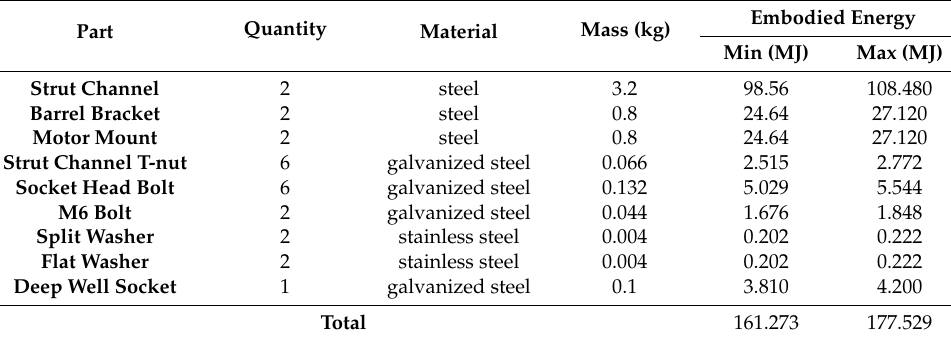
Table 2. Embodied energy for the frame assembly of the recyclebot.